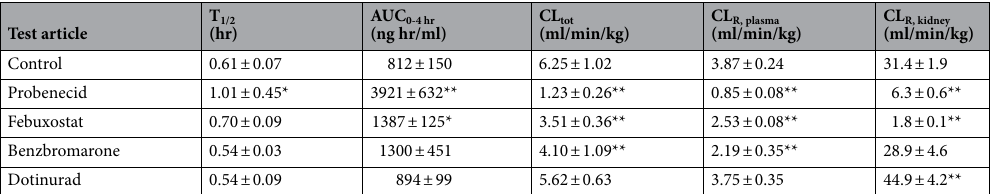
Table 3. Pharmacokinetic parameters of d 4 -IS in intact rats. T 1/2 : half-life, AUC 0-4 hr : area under the curve from 0 to 4 h, CL tot : total clearance, CL R, plasma : plasma concentration-based renal clearance, CL R, kidney : kidney concentration-based renal clearance. Data were analyzed using Phoenix WinNonlin 6.4 software (Certara, L.P., Princeton, NJ) or calculated using the following equations: CL R, plasma = (urine d 4 -IS concentration × urine volume) / AUC 0-4 hr , CL R, kidney = (urine d 4 -IS concentration × urine volume) / (kidney d 4 -IS concentration at 4 h × 4). Each value is presented as mean ± SD of four to six animals. *, **: P < 0.05, P < 0.01, significantly different from the control group according to Dunnett’s multiple comparison